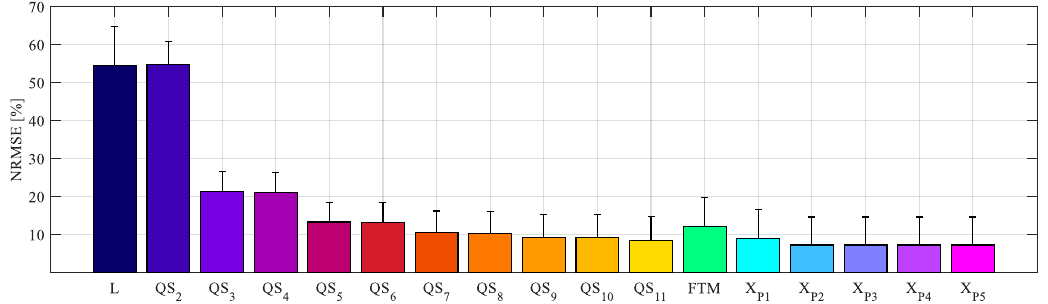
Figure 2. Normalized Root Mean Square Error (NRMSE) mean value and 95th percentile values for each considered model.